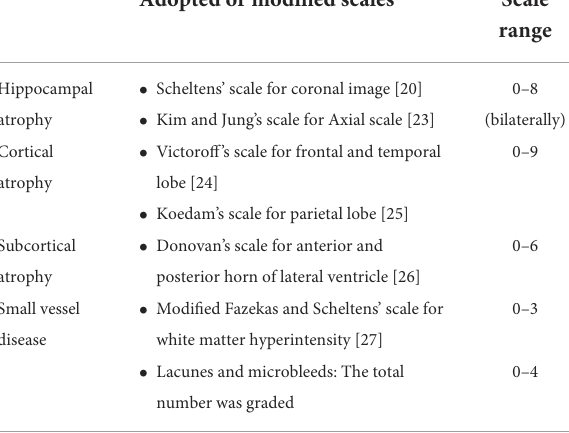
TABLE 1 Construction of a comprehensive visual rating scale